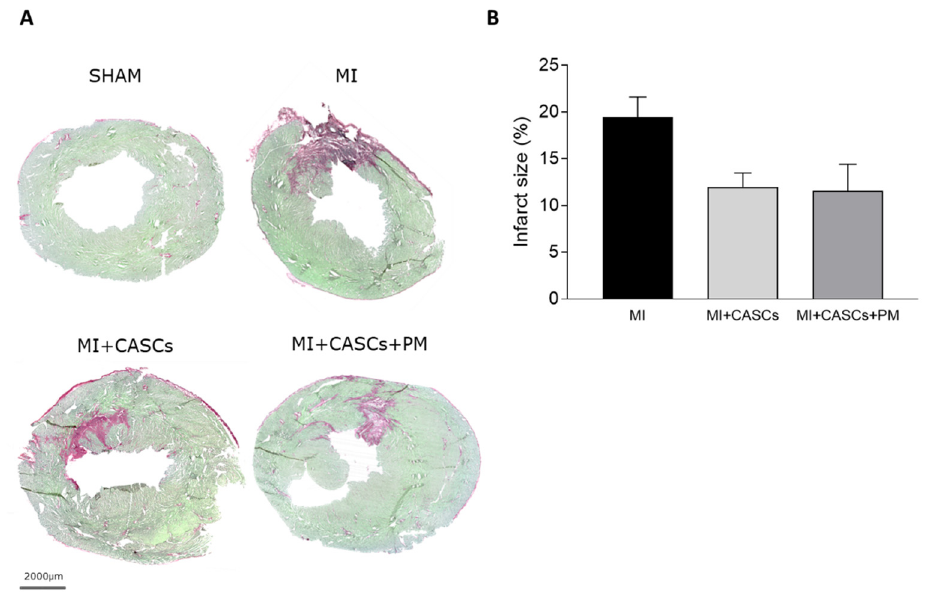
Figure 2. Assessment of infarct size. ( A ) Representative examples of hearts from SHAM, MI, MI + CASCs, and MI + CASCs + PM. Fibrotic tissue, as a surrogate for infarct size, is stained red, while viable tissue is stained green. Scale bar = 2000 µm. ( B ) Quantification of infarct size in transversal sections 4 weeks post-surgery. MI ( n = 11), MI + CASCs ( n = 10), and MI + CASCs + PM ( n = 5). Data are expressed as mean ± SEM.